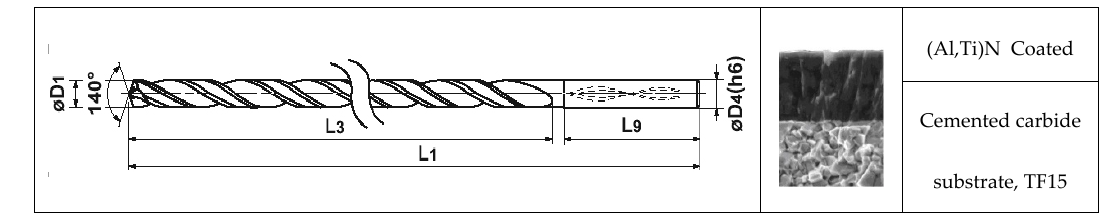
Figure 1. Drill bit (D1 = 4 mm, L1 = 74 mm, L3 = 36 mm, L9 = 36 mm, D4 = 6 mm). (Courtesy of Mitsubishi©).